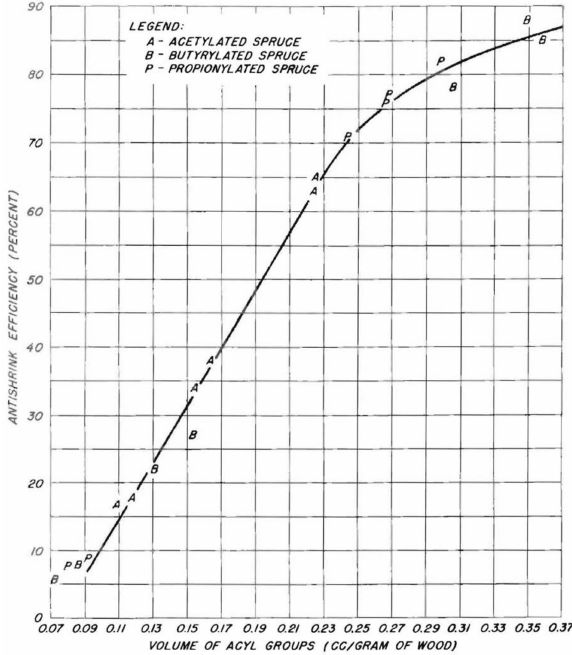
Figure 5. Relationship between volume of acetyl groups per gram of wood and antishrink effi- ciency [7].